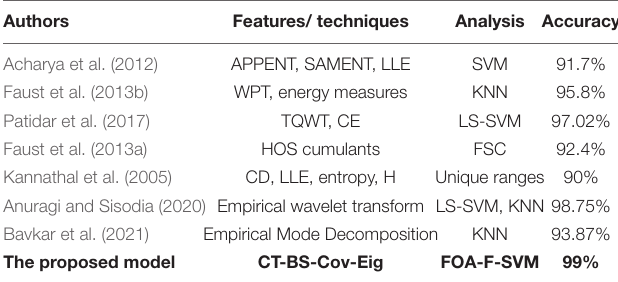
TABLE 10 | Comparison with existing methods using the same